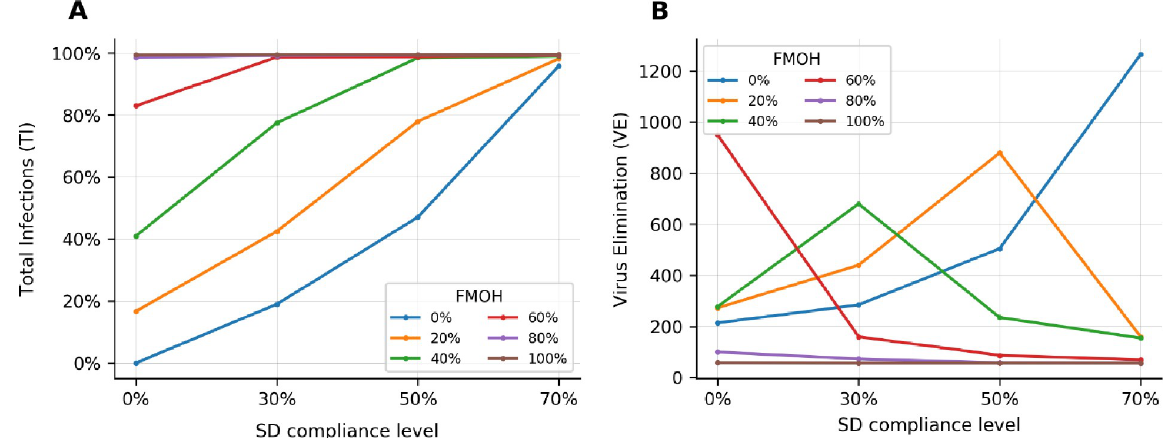
Fig 3. A comparison of different levels of FMOH and their interactions with SD levels when the TL is the same as pre-COVID. (A) The percentage of reduction in the cumulative number of infections (TI), (B) The time it takes the disease spread getting under control (VE). Note: the FMH is 0%.